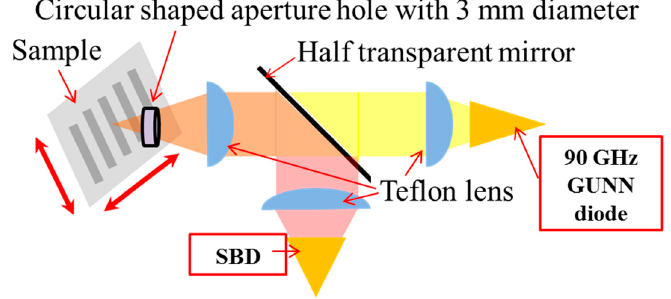
Figure 2. The optical schematic system of THz reflection imaging measurement. SBD: Schottky barrier diode.